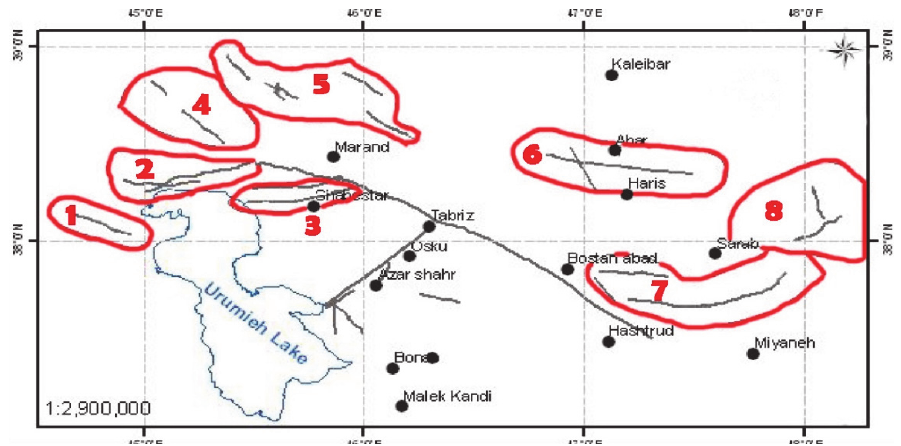
Fig. 4. East Azerbaijan seismic zonation map (Hoseinpour & Zare,